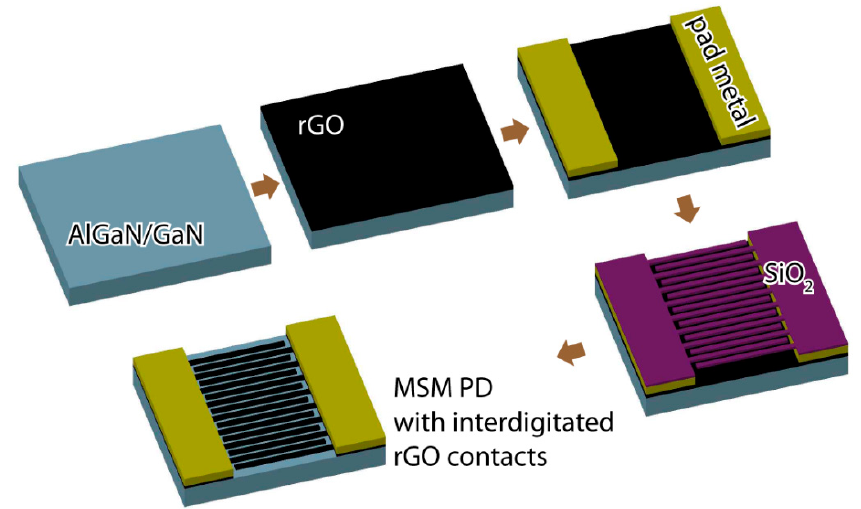
Figure 1. Schematic fabrication process for reduced graphene oxide (rGO)/AlGaN/GaN metal– semiconductor–metal (MSM)